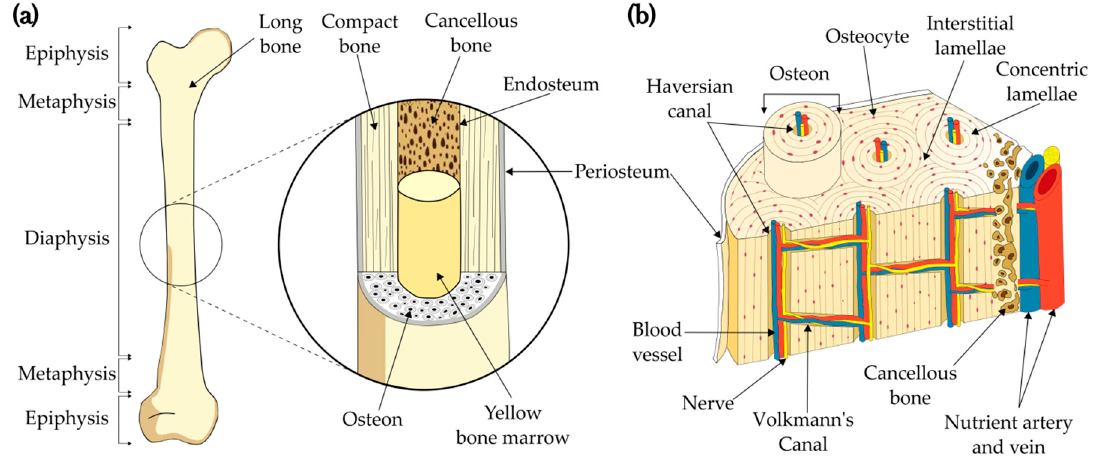
Figure 1. Schematic representation of an; ( a ) long bone and ( b ) microstructure.